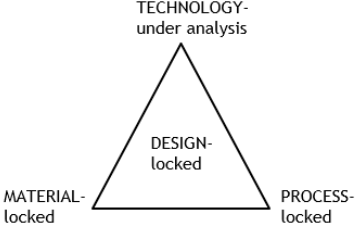
Figure 1. Key elements considered for the benchmarking design approach, adapted from [27].